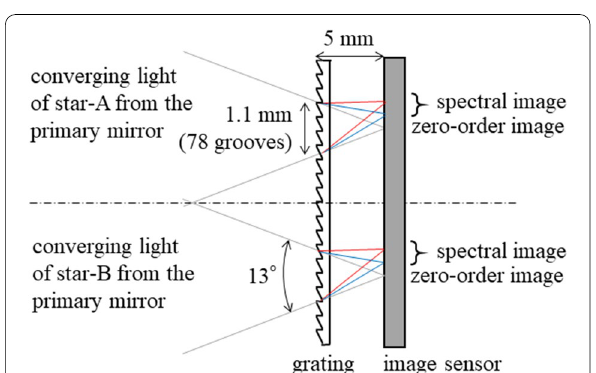
Fig. 13 In our simple spectral camera, the converging light of a star passes the grating and focuses on the image sensor in our camera. The effective region of the grating depends on where the light focuses on the image sensor. The converging angle of 13° is calculated from the focal length and the aperture of our